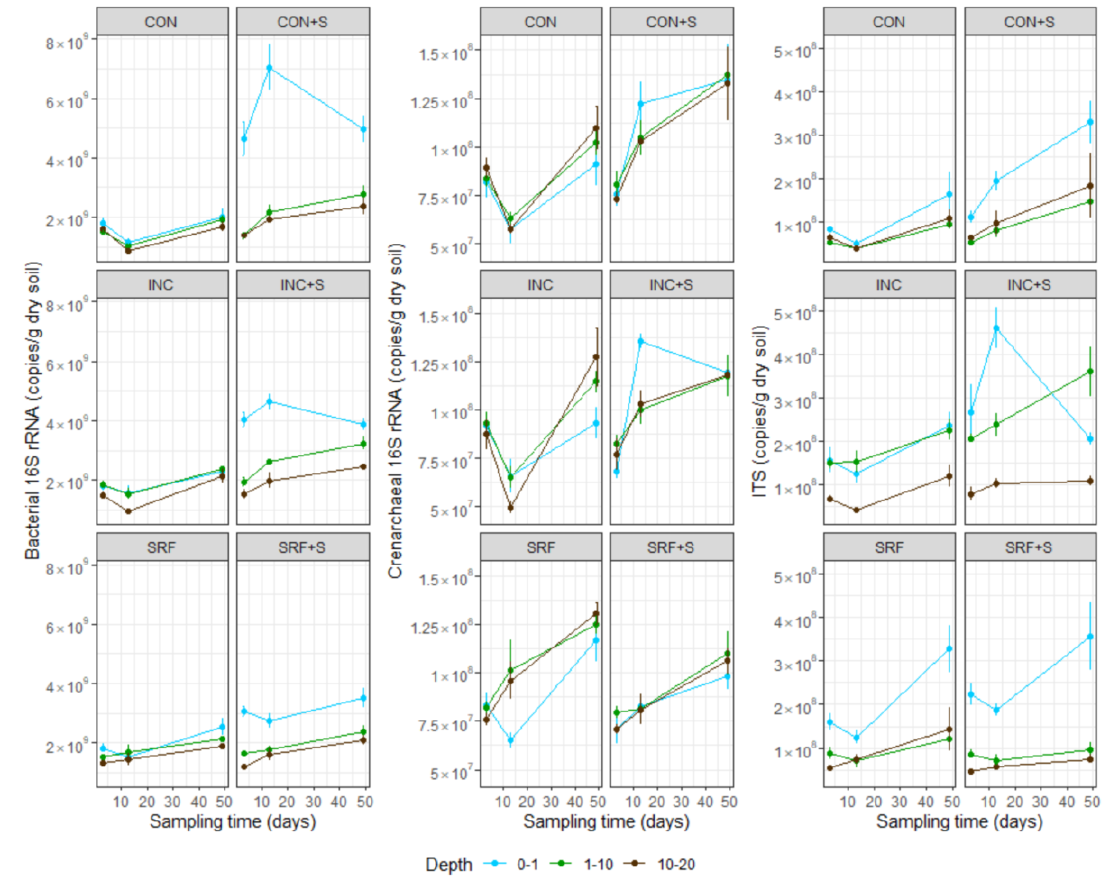
Figure 3. Dynamic of bacterial, crenarchaeal 16S rRNA and fungal ITS copy numbers in CON (control), INC (straw incorporated in 0–10 cm soil layer) and SRF (straw applied at the soil surface) soil treatments in presence/absence of slurry (S) at three sampling depths (cm). Averages and standard errors of 4 replicates are